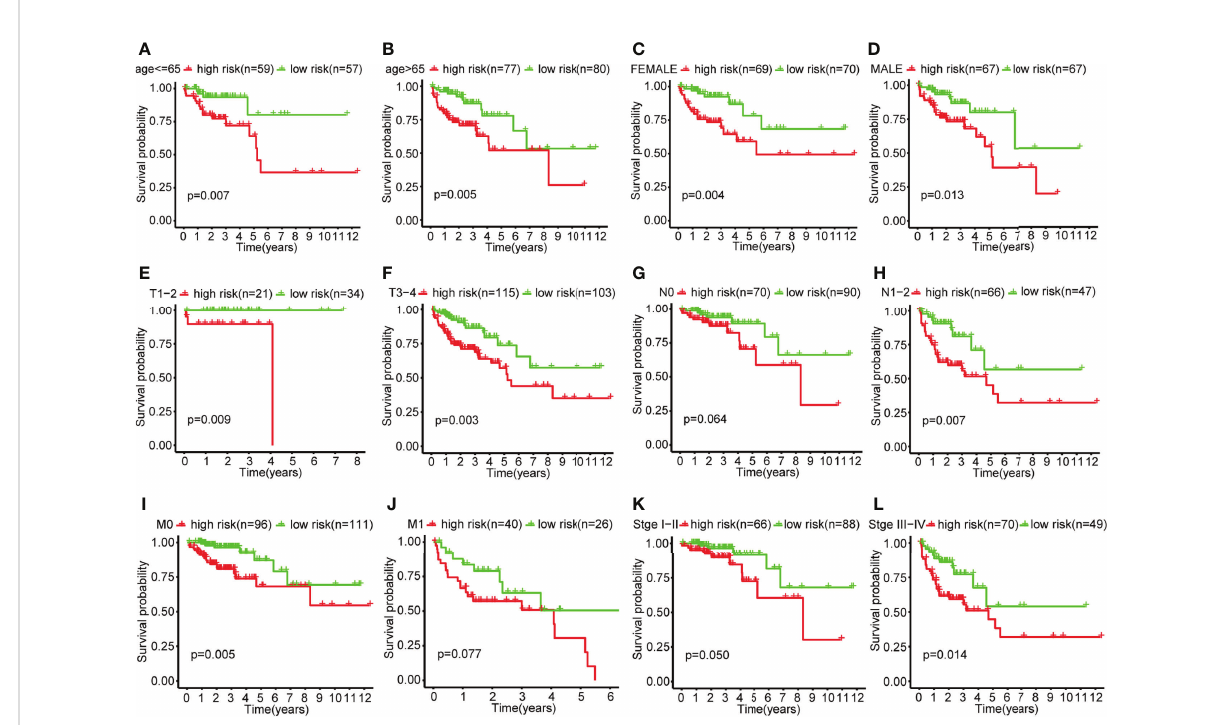
FIGURE 4 Survival curves in each clinical subgroup of the high-risk and low-risk group of colon cancer patients. (A) Survival curves of the high-risk and low-risk groups in the age ≤ 65 subgroup. (B) Survival curves of the high-risk and low-risk groups in the age>65 subgroup. (C) Survival curves of the high-risk and low-risk groups in the female subgroup. (D) Survival curves of the high-risk and low-risk groups in the male subgroup. (E) Survival curves of the high-risk and low-risk groups in the T1-2 subgroup. (F) Survival curves of the high-risk and low-risk groups in the T3-4 subgroup. (G) Survival curves of the high-risk and low-risk groups in the N0 subgroup. (H) Survival curves of the high-risk and low-risk groups in the N1-2 subgroup. (I) Survival curves of the high-risk and low-risk groups in the M0 subgroup. (J) Survival curves of the high-risk and low-risk groups in the M1 subgroup. (K) Survival curves of the high-risk and low-risk groups in the stageI-II subgroup. (L) Survival curves of the high-risk and low-risk groups in the stageIII-IV subgroup.